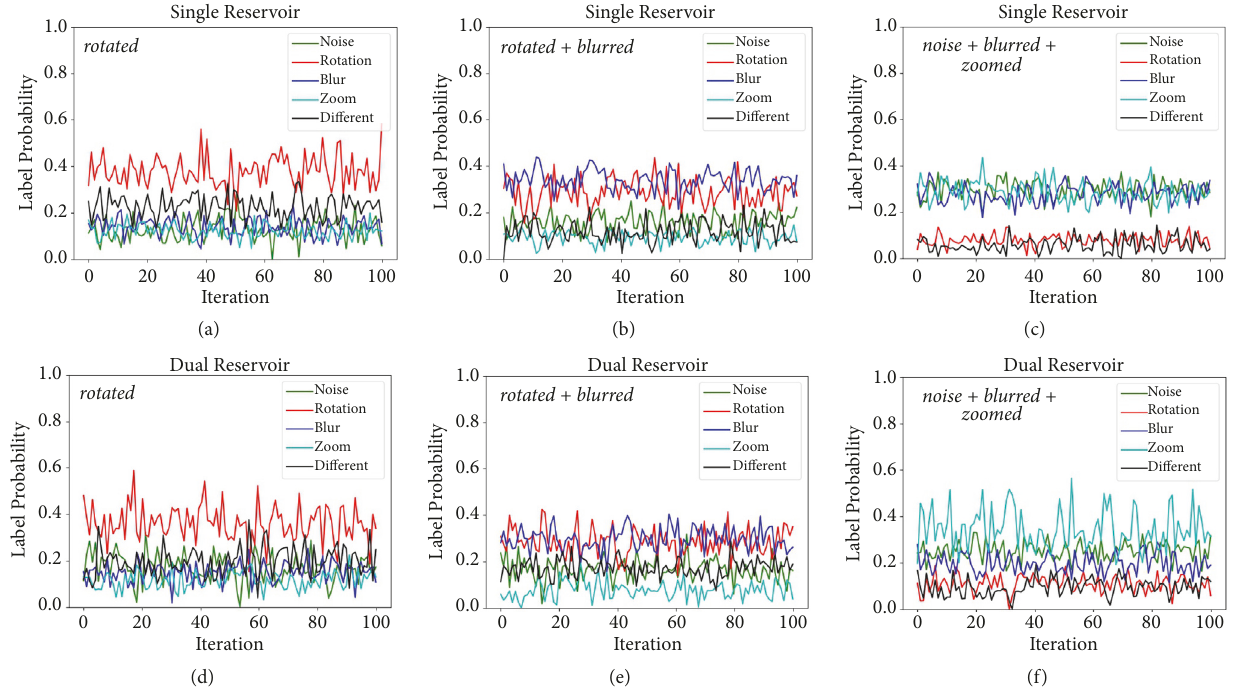
Figure 8: Graphing probabilities of the reservoir output ( 𝑦 𝑘 ) versus the image pair number 𝑘 , for image pairs that are rotated (a, d) 2 combination: rotated and blurred (b, e); 3 combination: noise, blurred, and zoomed (c, f), for single and dual reservoir, respectively. The fractions correct, where classification is considered to be correct if the 𝑛 predicted maximum probability labels are the 𝑛 transformations applied to the test image pair (shown on top left of each panel), are 0.97 , 0.97 , 1.0 , 0.93 , 0.84 , and 0.93 for (a, b, c, d, e, f), respectively. 𝛾 =0.5; reservoir size=1000. Training digits: 0-5; testing digits: 6-9. Training size: 250